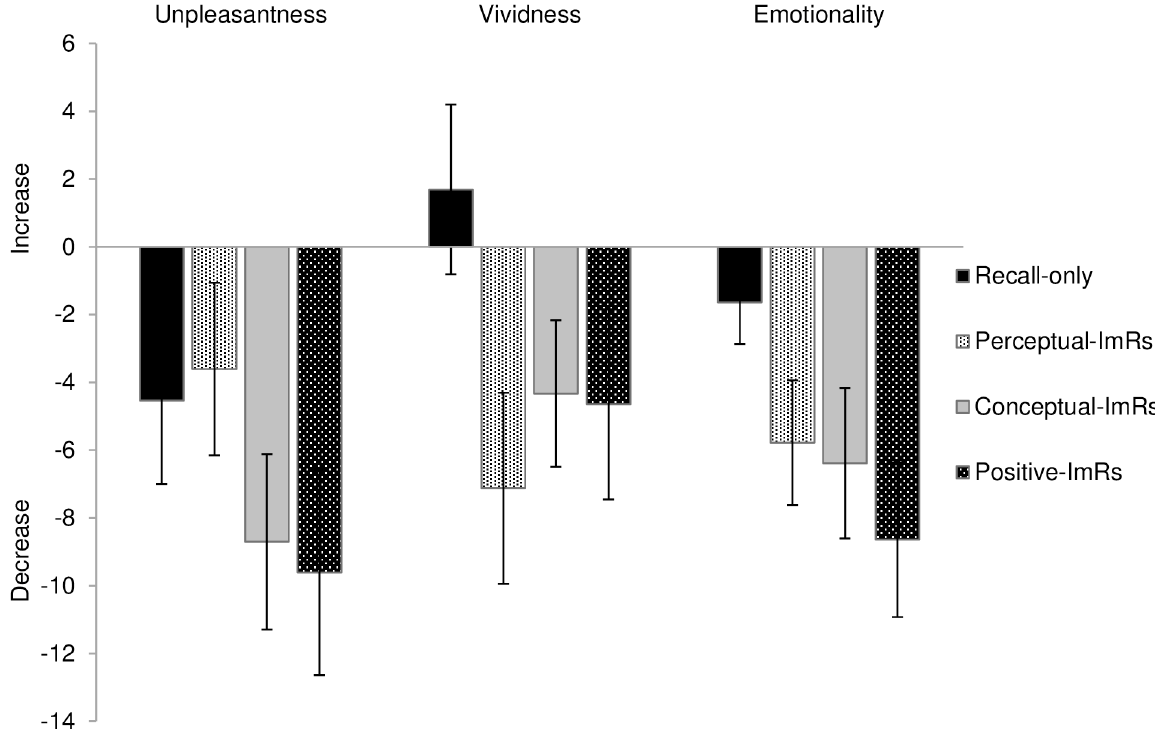
Fig 2. Changes in unpleasantness, vividness, and emotionality scores per condition (in mm; post-measurement – pre- measurement; positive scores indicate increases). Bars represent SEM. ImRs = Imagery